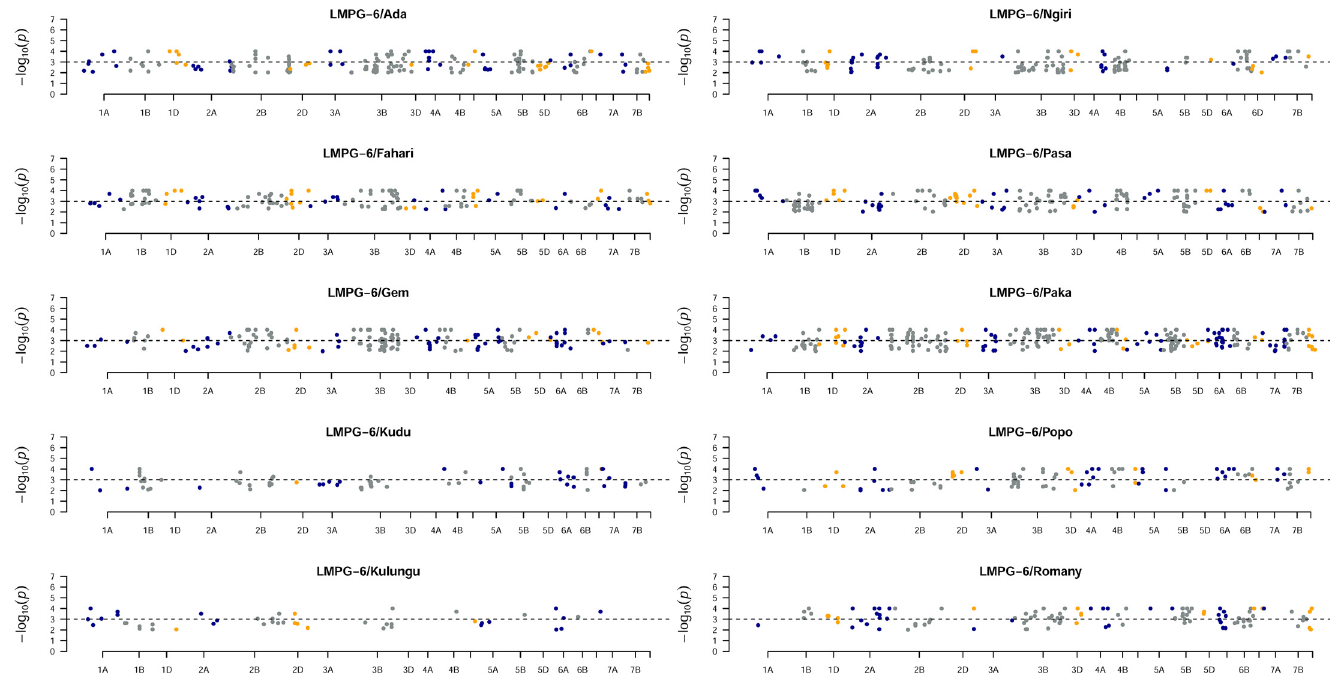
Fig 2. Segregation distortion of loci across each RIL mapping population. Chromosome names and the — log( p ) value for SNP markers in respective chromosomes for each population is